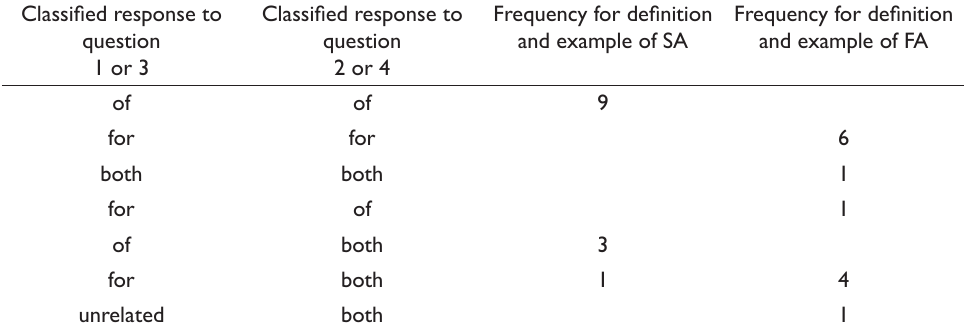
Table 2: The consistency of classified responses comparing first definitions given with examples given for both SA and FA. Numbers refer to frequency of responses that were classified according to the scheme in columns 1 and 2 (‘for learning’ (for), ‘of learning’ (of), both, and unrelated). Only recorded permutations are